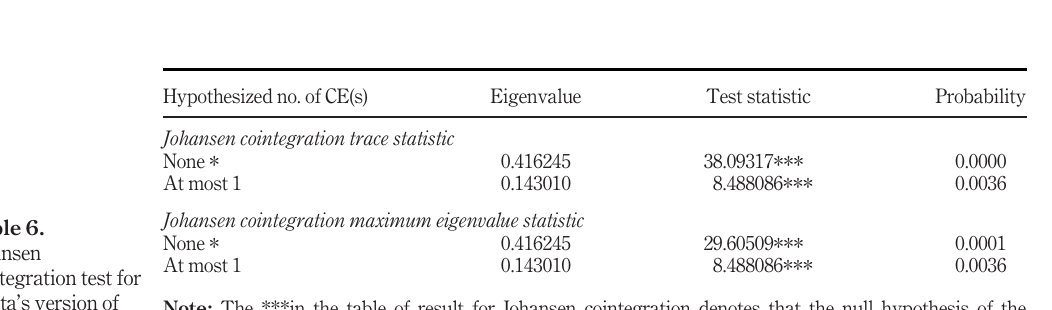
Table 5. Johansen cointegration test for Pryor ’ s version of